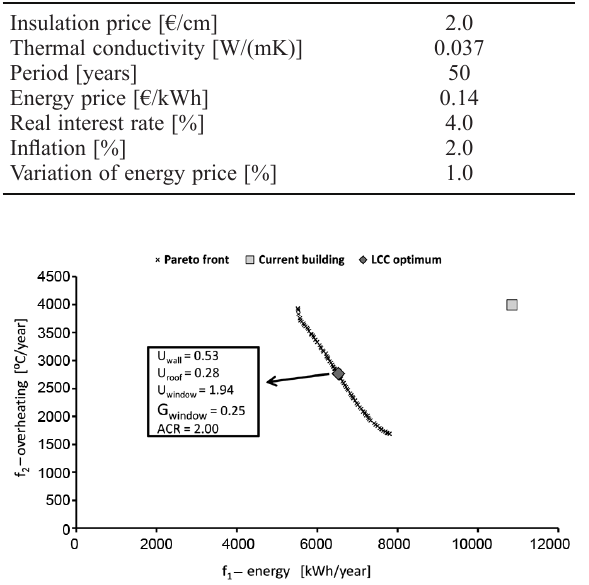
Fig. 7. Example case: